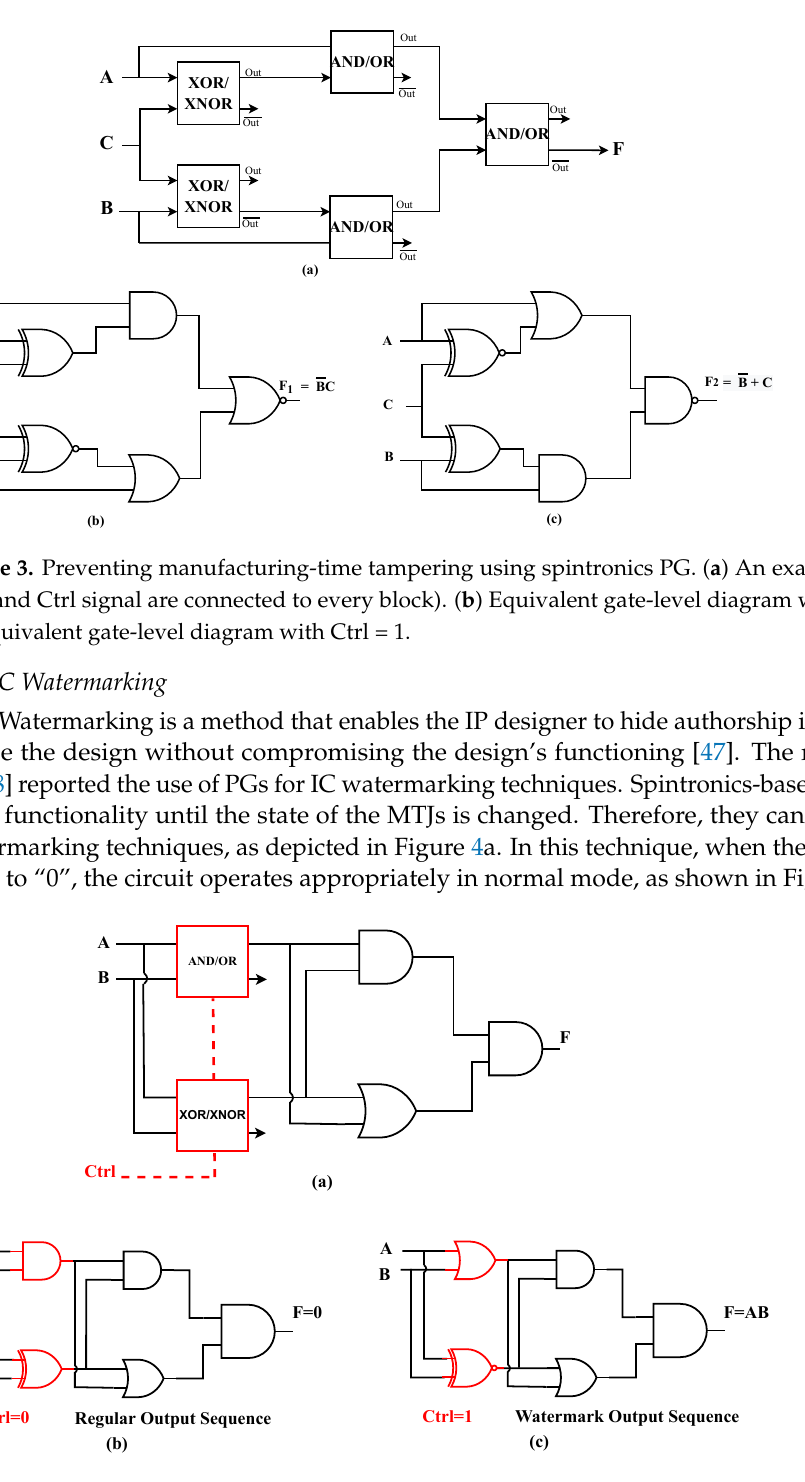
Figure 4. IC watermarking using spintronics PG. ( a ) An example circuit (Clk is connected to both blocks). ( b ) Equivalent circuit giving regular output sequence at Ctrl = 0. ( c ) Equivalent circuit giving watermark output sequence at Ctrl =